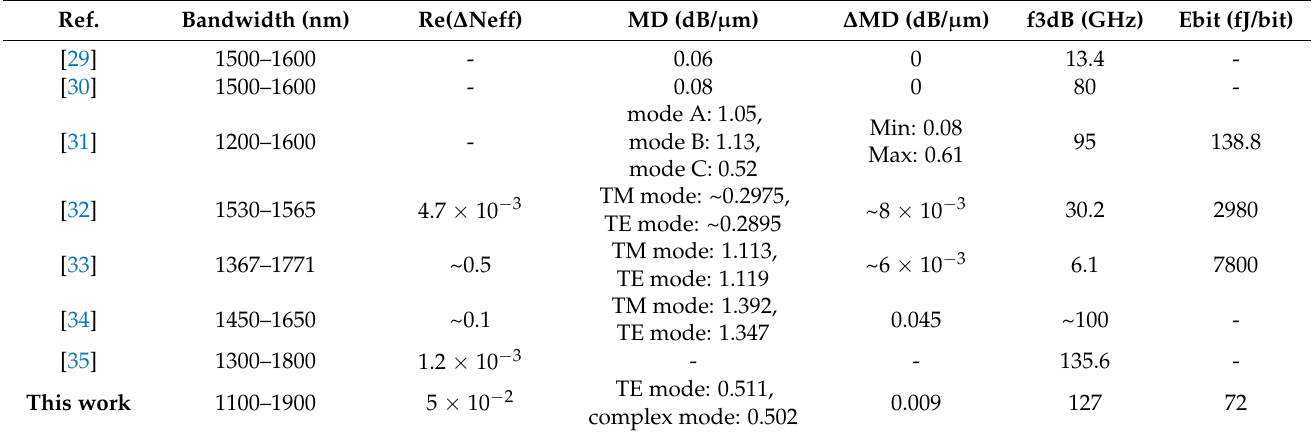
Table 1. Modulator performance comparison with reported